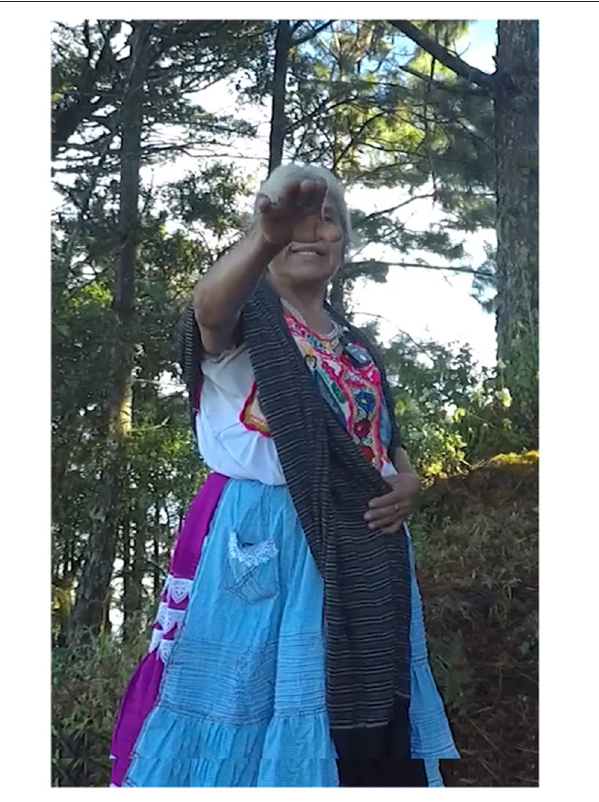
FIGURE 5 | District scale [target: Santa Catarina